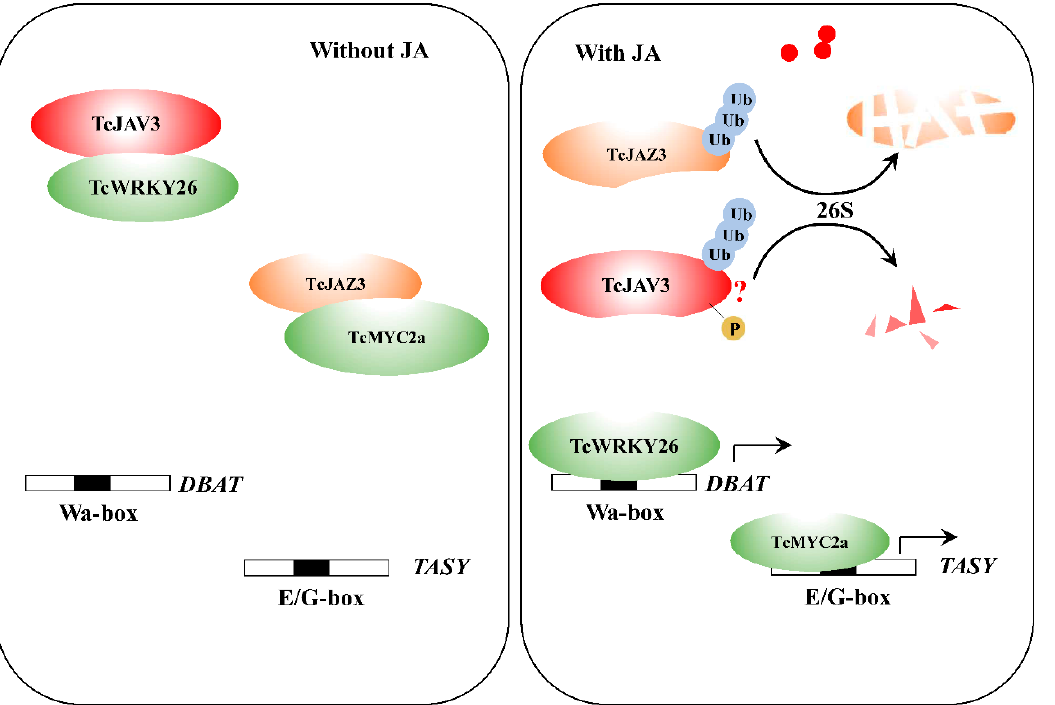
Figure 5. JA regulation mechanism of taxol biosynthesis. Without JA molecules, the TcWRKY26 and TcMYC2a were physically interacted with and inhibited by TcJAV3 and TcJAZ3, respectively. However, when plants suffered attacks of insects and pathogens, TcJAV3 and TcJAZ3 were ubiquitination degraded, TcWRKY26 and TcMYC2a were released to activate DBAT and TASY genes. However, according to current reports, there is another way: the triplet of JAZ–JAV–WRKY was destructed when JAV was phosphorylated, and then WRKY was released. Further studies were needed to clarify the details of the